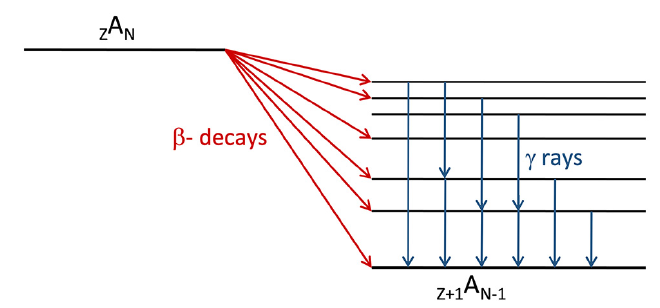
Fig. 1. – Example of a typical β -decay scheme of